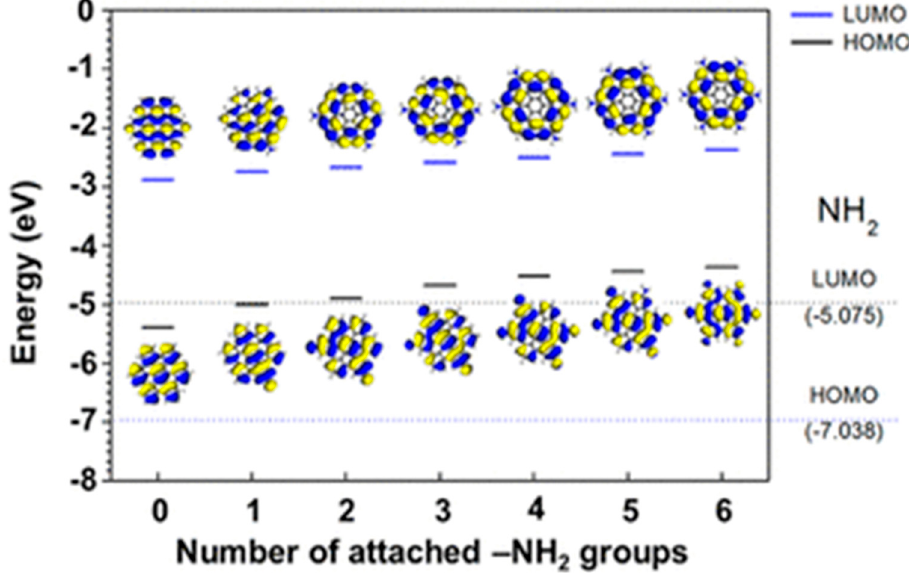
Figure 11. Systematic variations in HOMO–LUMO energy levels and the bandgaps due to increasing the number of attached -NH 2 groups. Reprinted with permission from Ref. [105].